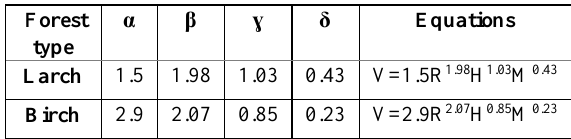
Table 1. Coefficients and volume equations for the forests in the study area